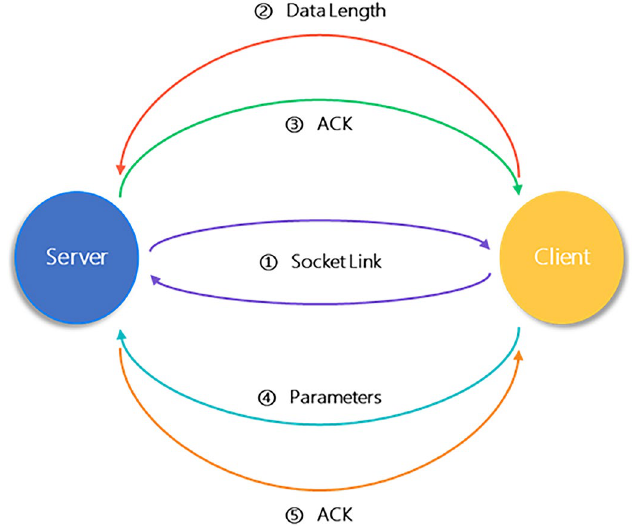
Figure 7. Diagram of the communication strategy between the server and the